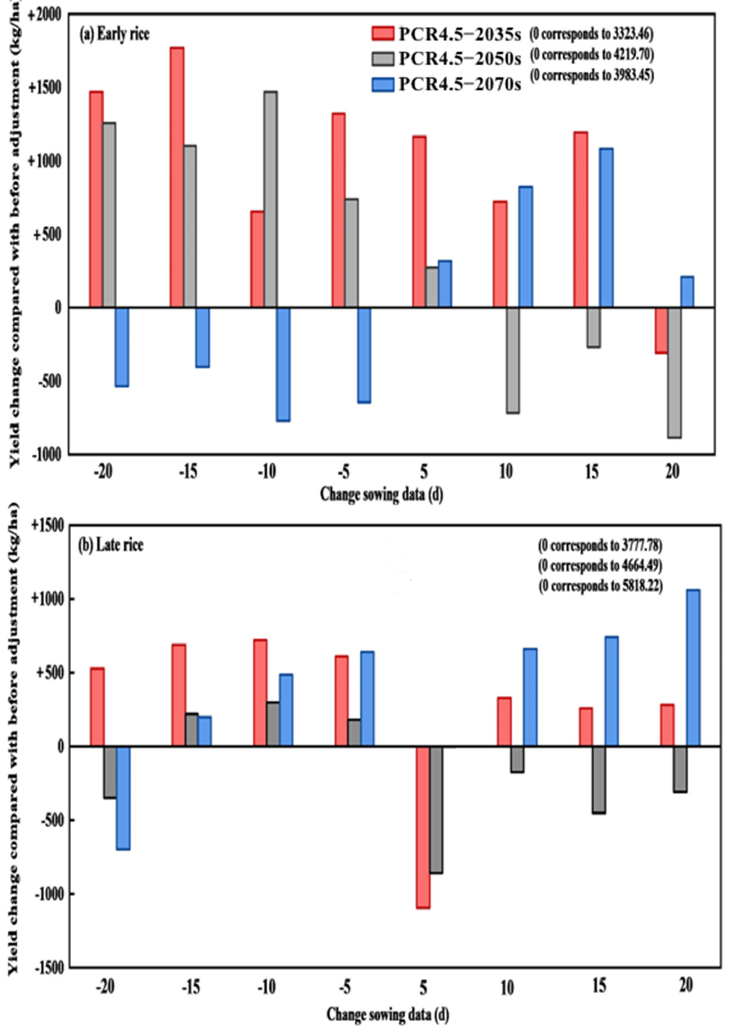
Figure 8. The effect of changing the sowing date of double-harvest rice on its yield.